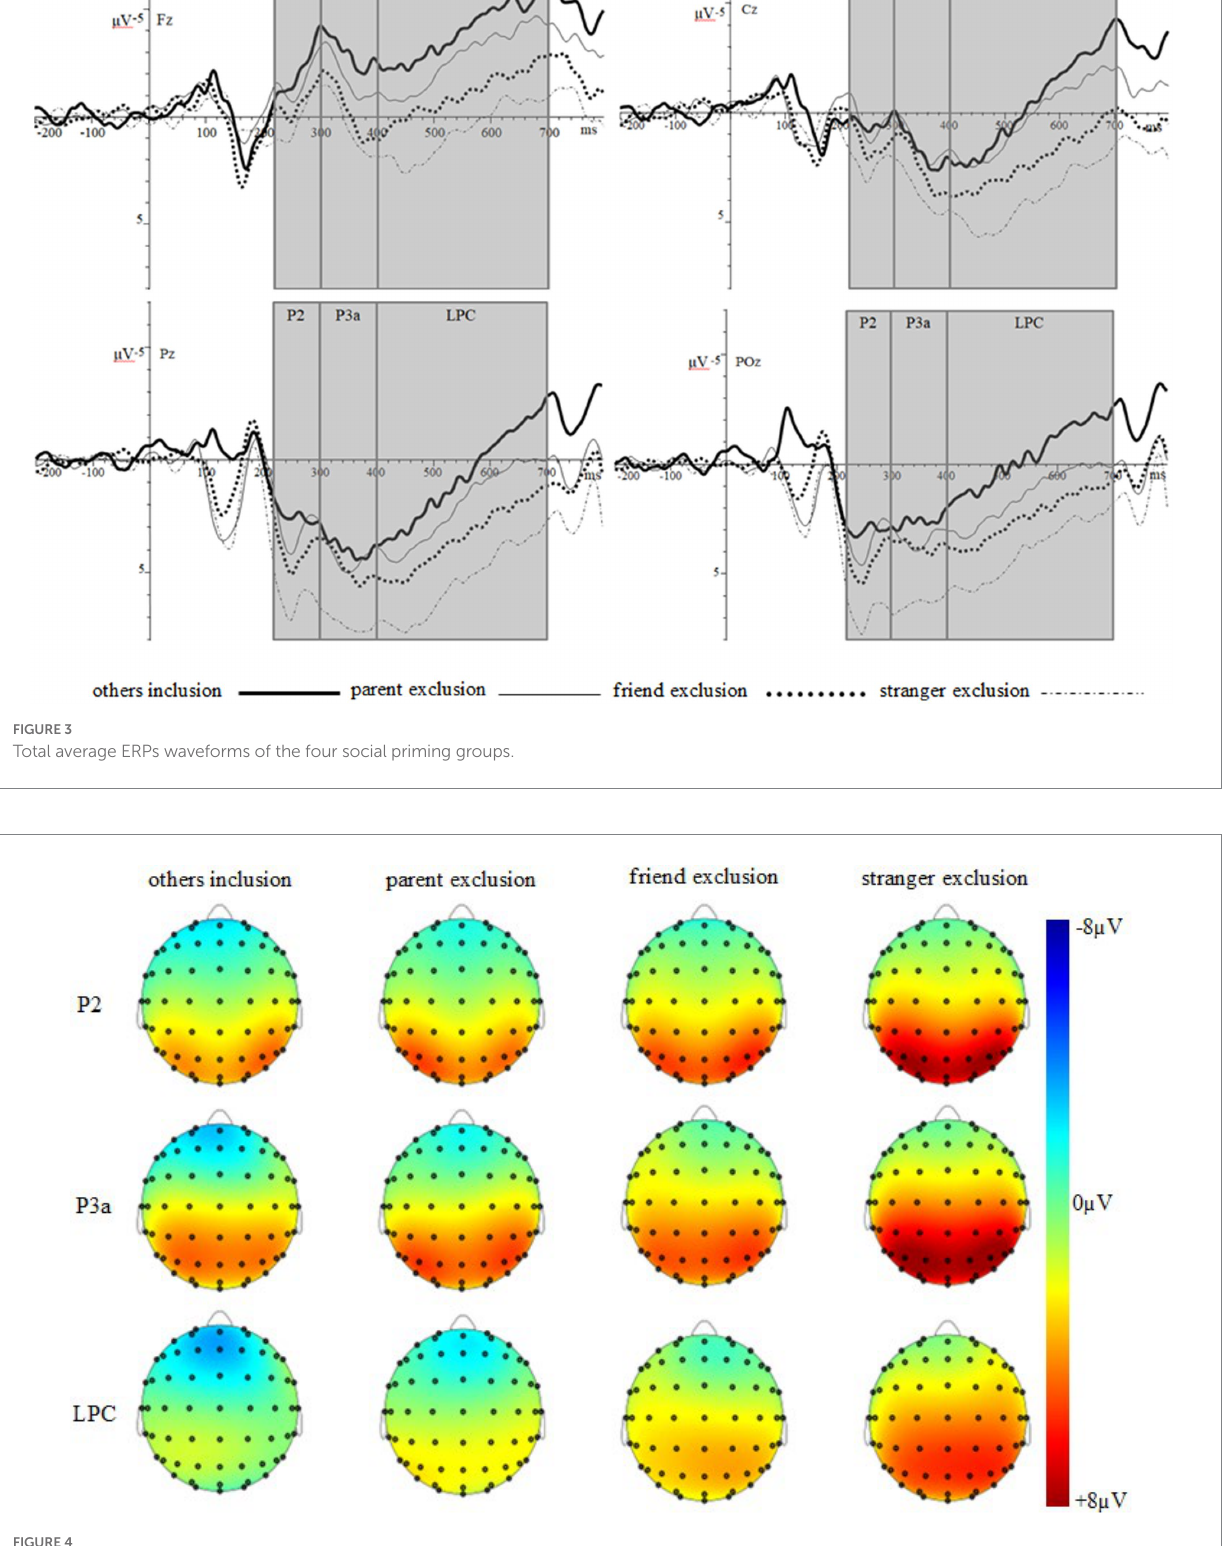
FIGURE 4 Topographic maps of the four social priming